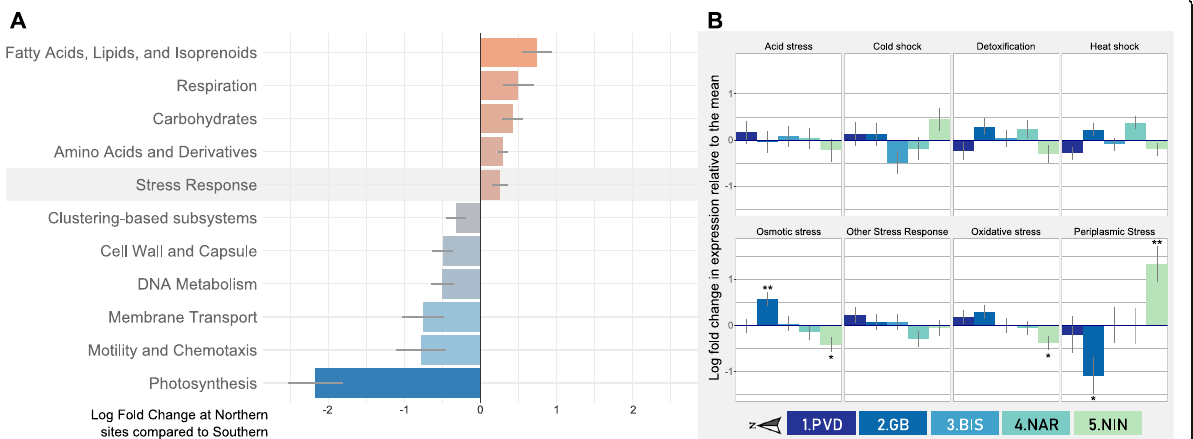
Fig. 5 Pathways showing significant differential gene expression patterns between sites. a Differential expression of all significant (Benjamini- Hochberg p adj < 0.05) Level 1 pathways at the Northern sites (1 – 3, n = 15), compared to Southern sites (4 – 5, n = 10). A red bar (fold change> 0) indicates upregulation in the North and a blue bar (fold change< 0) indicates downregulation in the North. b Differential expression of Level 2 Stress Response pathways at each site, relative to the mean of all other sites ( n = 5, Benjamini-Hochberg * p adj < 0.05, ** p adj < 0.01)